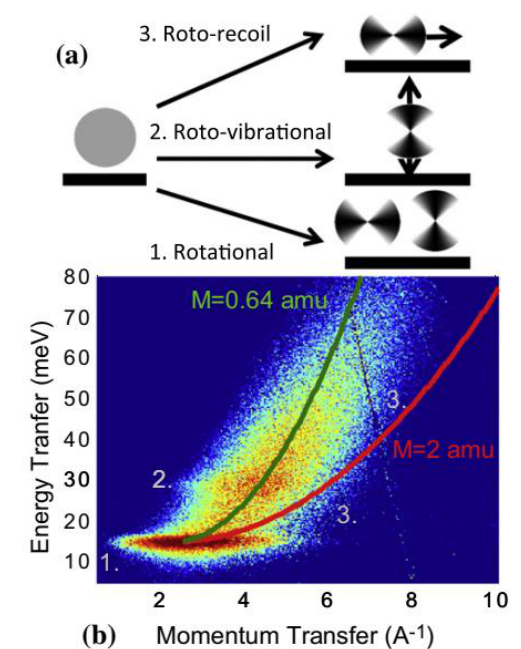
Figure 3. ( a ) Cartoon of various molecular motions of H 2 in a nanotube, as conventionally expected. ( b ) Experimental Incoherent Neutron Scattering (INS) results from H 2 in carbon nanotubes. Incident neutron energy: E 0 = 90 meV; Figure 1 of [28]. The translation motion of the recoiling H 2 molecules causes the observed continuum of intensity, usually called “roto-recoil” (yellow-orange ribbon). The K − E position of the first rotational excitation of H 2 (dark red-brown ellipsoid). agrees with conventional theoretical expectations. In clear contrast, a detailed fit (green parabola) to the roto-recoil data yields the effective mass of translating H 2 to be M ef f ≈ 0.64 a.m.u. The red parabola on the right shows the conventional-theoretical parabola associated with the H 2 -mass M = 2 a.m.u. See the text for more explanations. (Reproduced from [28], with permission of Elsevier